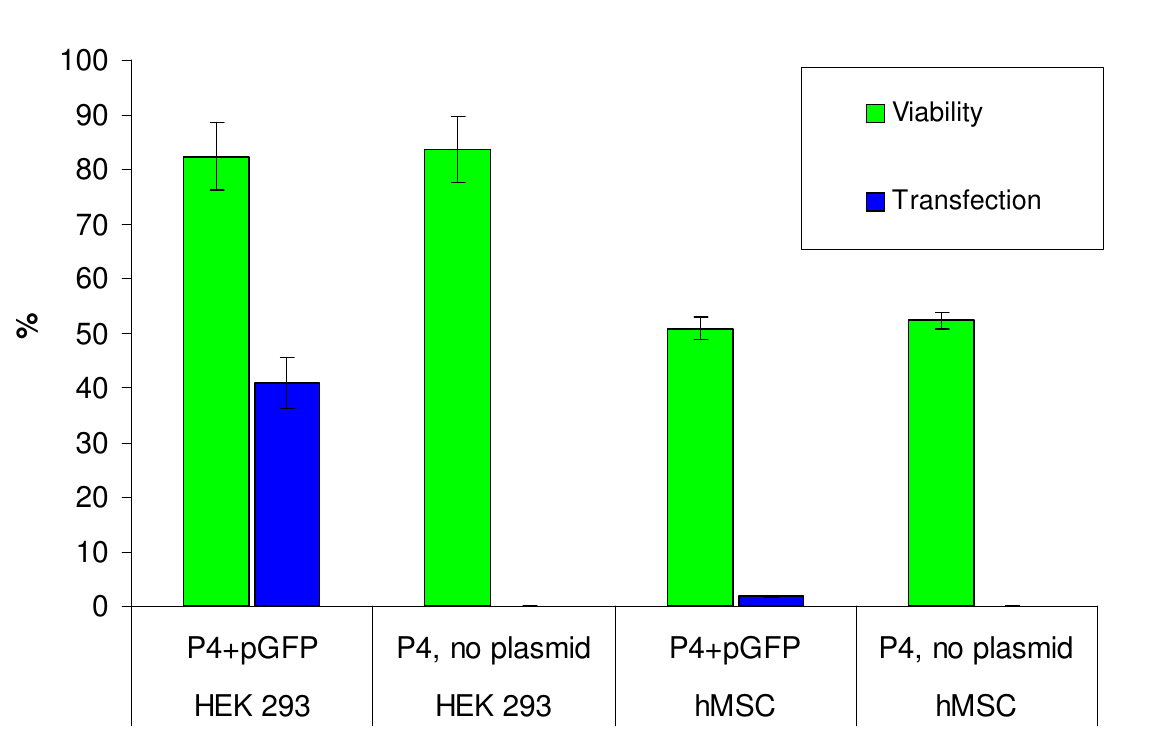
Figure 7. Transfection rate and cell viability parameters for P4 dendrimer in HEK 293 cells and